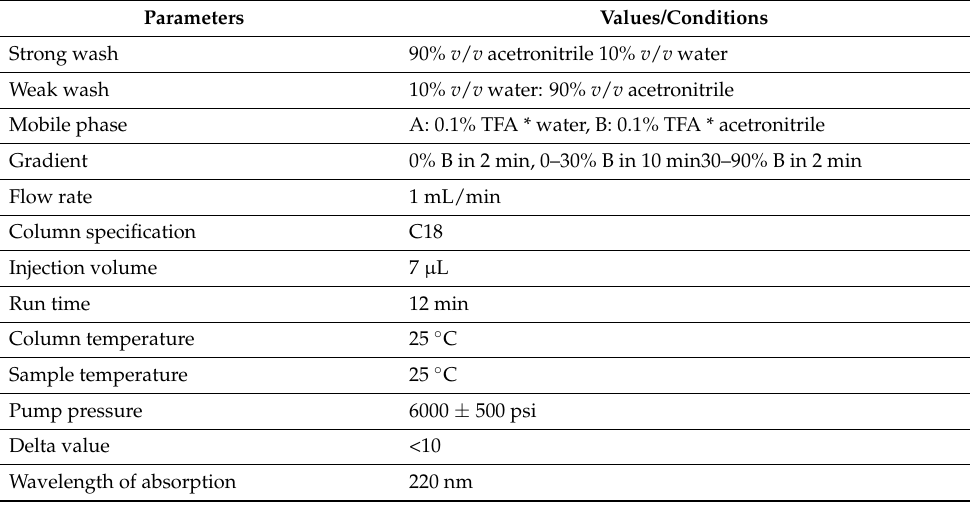
Table 1. UPLC (ultra performance liquid chromatography) specifications and method